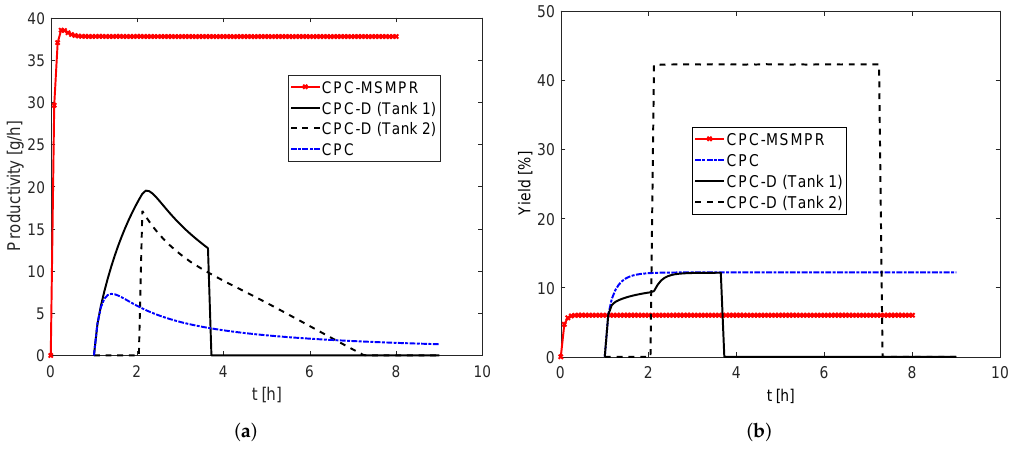
Figure 10. ( a ) Comparison of productivities for various process configurations. Process parameters used are seed mass 8 g, feed flow rate rate 80 mL min − 1 , exchange rate 80 mL min − 1 , and racemate mass 70 g. The productivity for coupled preferential crystallization in MSMPR crystallizers (CPC-MSMPR) is found to be the highest. The sudden rise and fall of productivities for the coupled preferential crystallization-dissolution (CPC-D) configuration is due to the use of cut-off purity of ee S = 99%; ( b ) Curves showing comparison of yields. The yield of CPC-MSMPR is the lowest. The relatively high yield of CPC-D configuration in Tank 2 is due to the use large amount of racemic